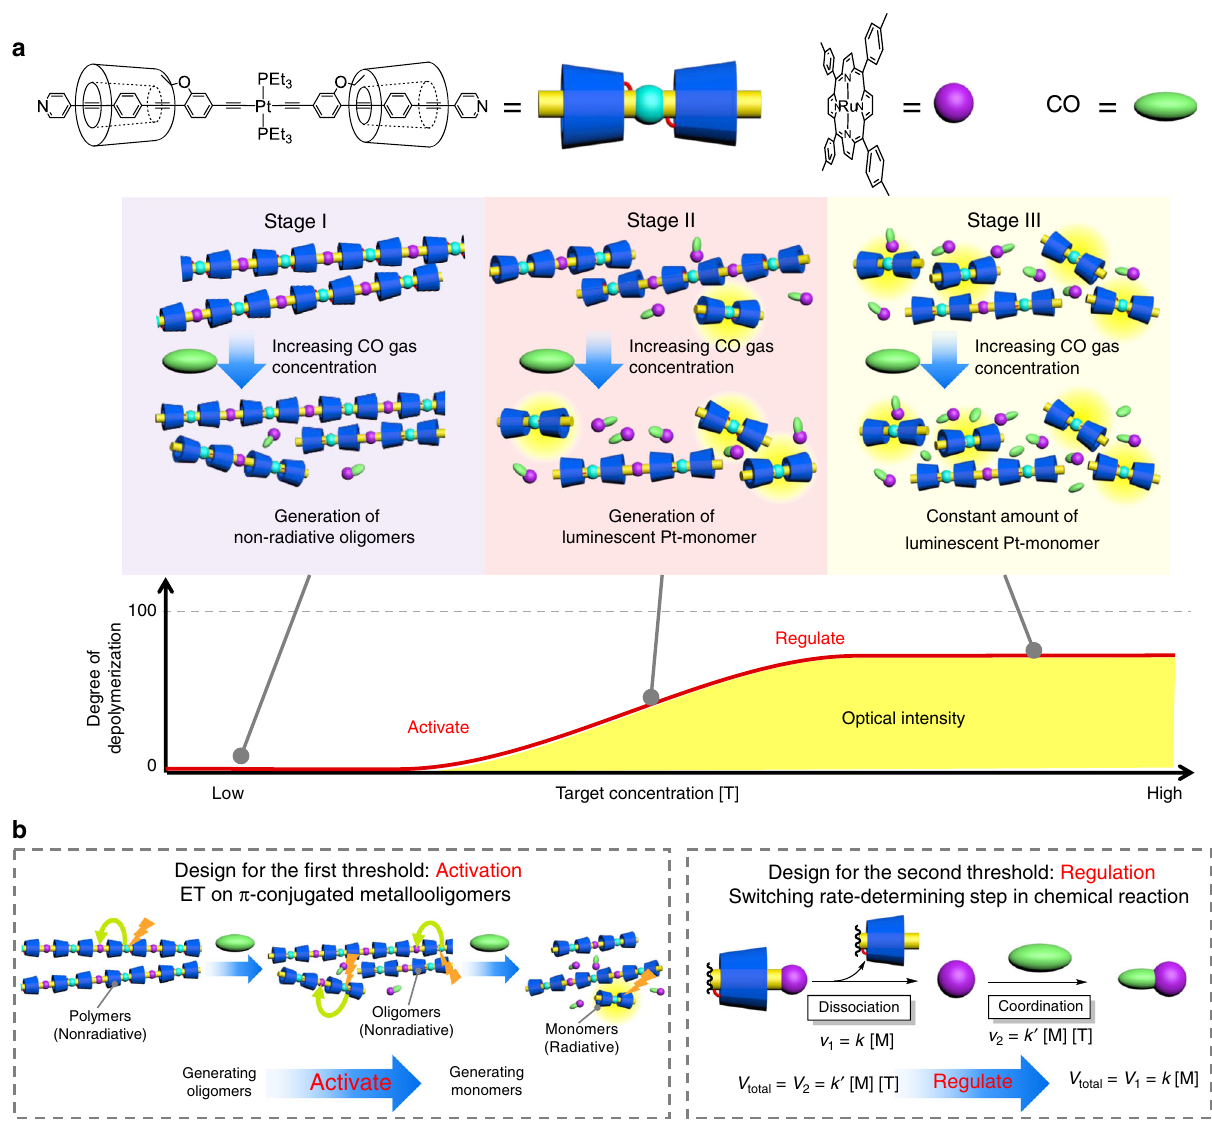
Fig. 5 Summary of the depolymerization steps with two thresholds. a Change in the optical intensity with increasing target concentrations. b The design principle for self-activation and self-regulation ([M]: concentration of sensing metal, [T]: target concentration, k and k ′ reaction rate constants).